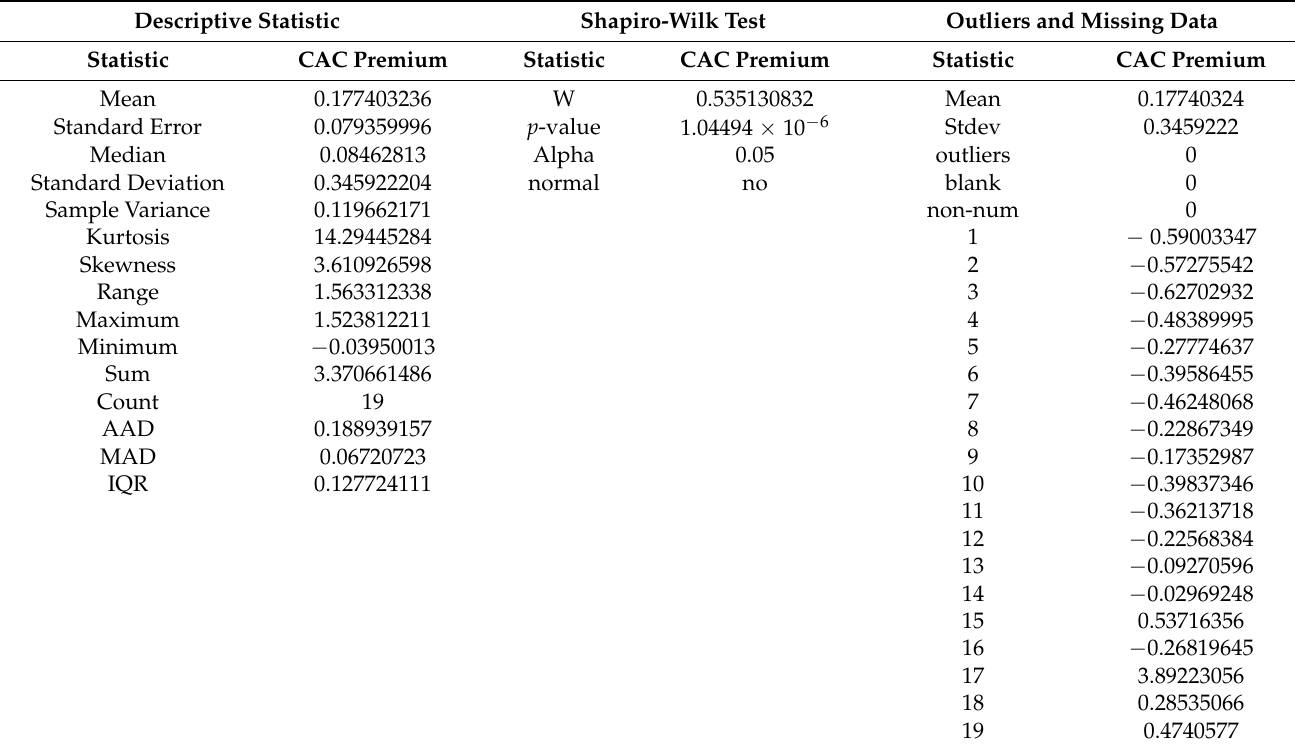
Table A4. Descriptive Statistics 5-year sovereign bond and result (Source: Authors).